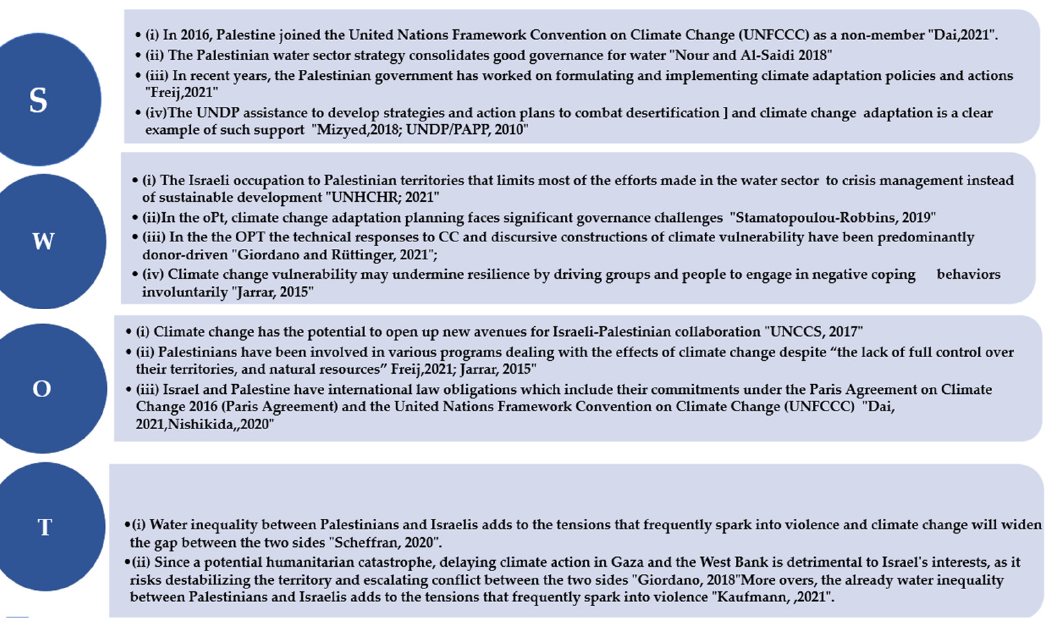
Figure 7. Key dimensions in OPT’s water crisis and climate change challenges (source: created by authors) [16,18,20,24,27,32,40,41,47,56,62,76–78].